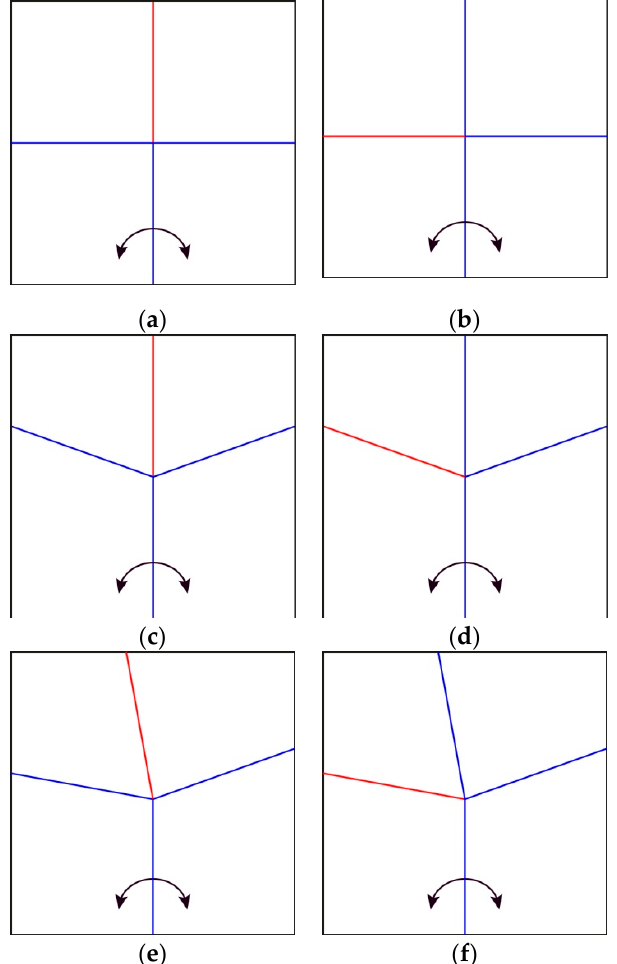
Figure 10. Crease patterns of the three original unit cells for this study. ( a , b ) Presents a folding pattern with four 90° angles meeting in one node. ( c ) Is the representation of one cell of a Miura crease pattern [10]. ( d ) Is an adaptation of a Miura-ori unit cell to a second type of folding. ( e , f ) are based on drawings from Haas’ and Wootton’s abstraction of insect wings. The left column ( a , c , e ) displays one type of folding where the one reversed crease is on the opposite side of the angle generating the folding and unfolding. The right column ( b , d , f ) shows the same patterns with the reversed crease on one of the sectors used to open or close the angle. The arrows present the opening angle, triggering the pattern unfolding.